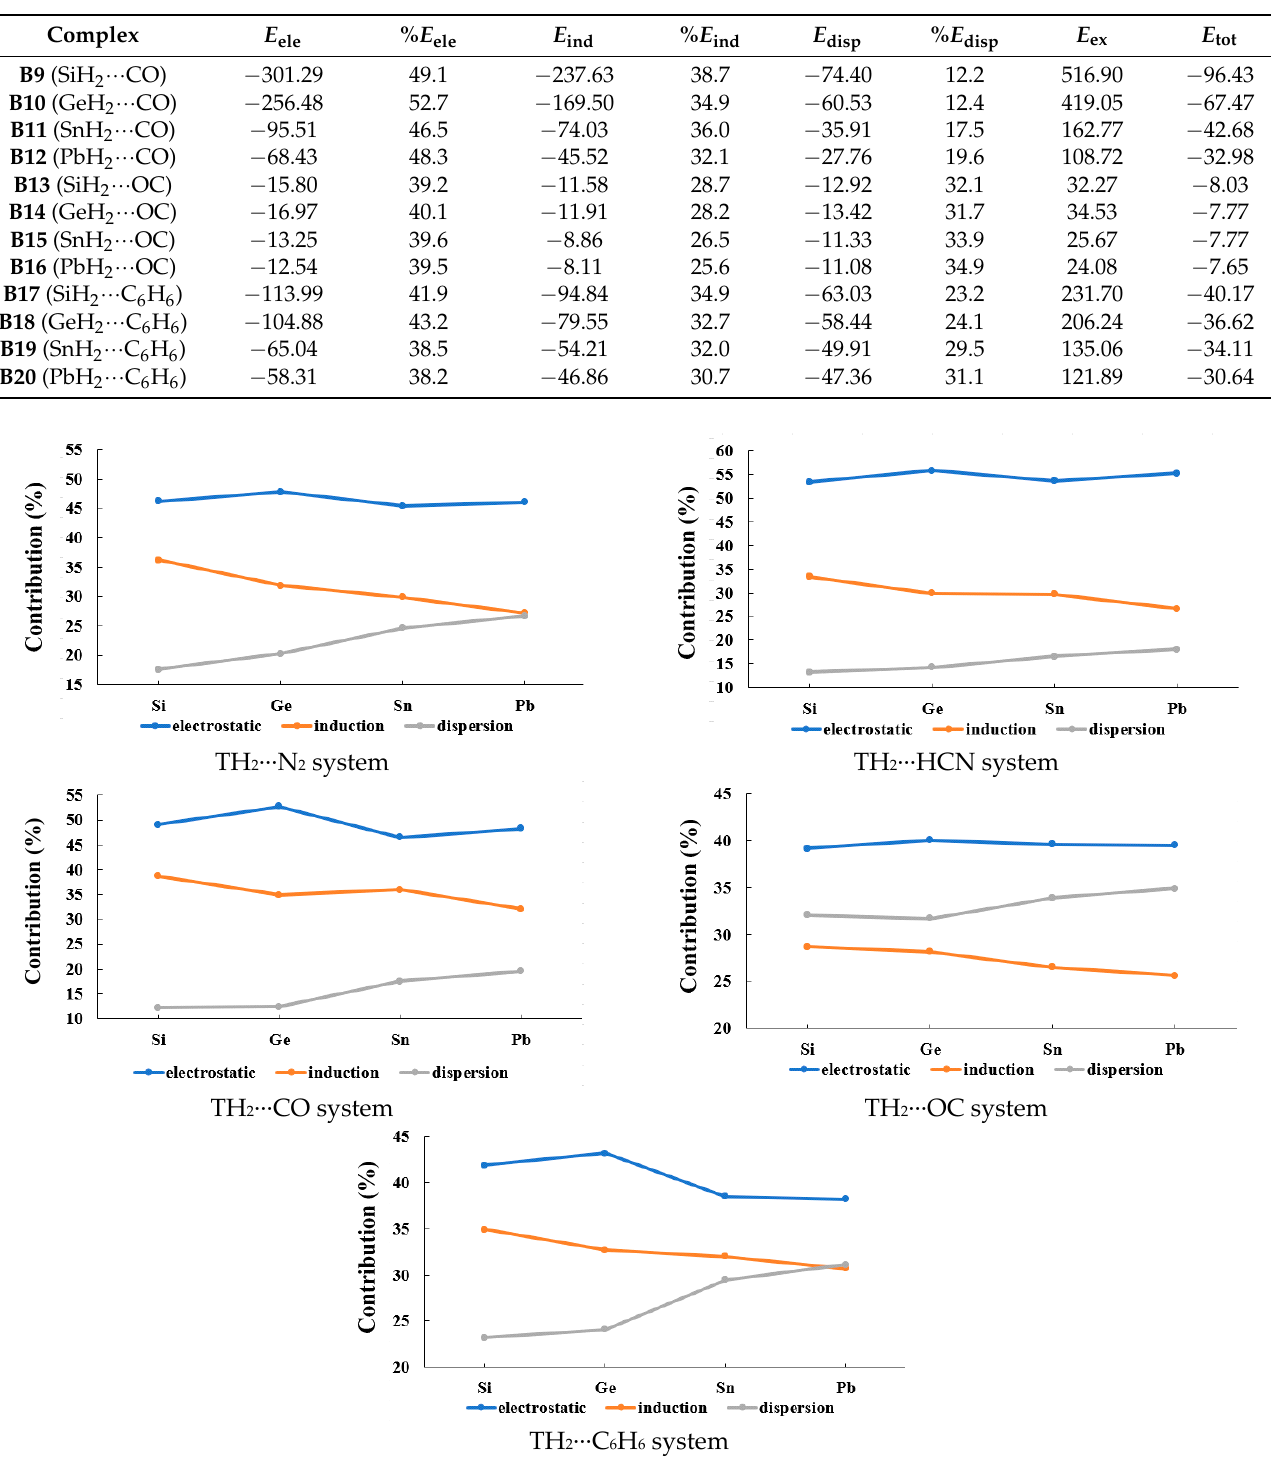
Figure 11. The changing trends of the contribution of the electrostatic, induction, and dispersion energy terms with the increase of the T atomic number for the type-B complexes.